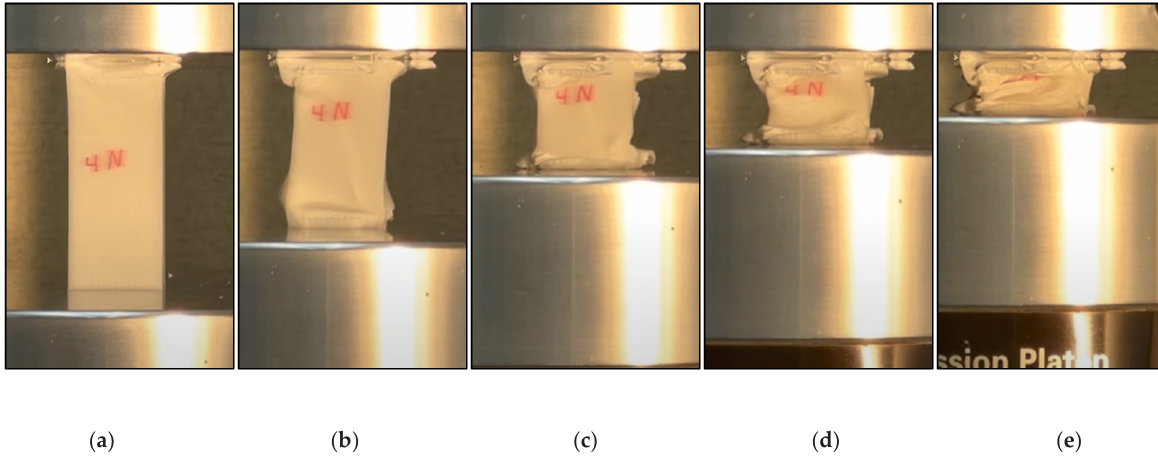
Figure 8. Experimental compression test of the novel cell under axial load during the different stages graphed in Figure 7: ( a ) First collapse; ( b ) Second collapse ( c , d ) Between 20 mm and 42 mm; and ( e ) Densification.